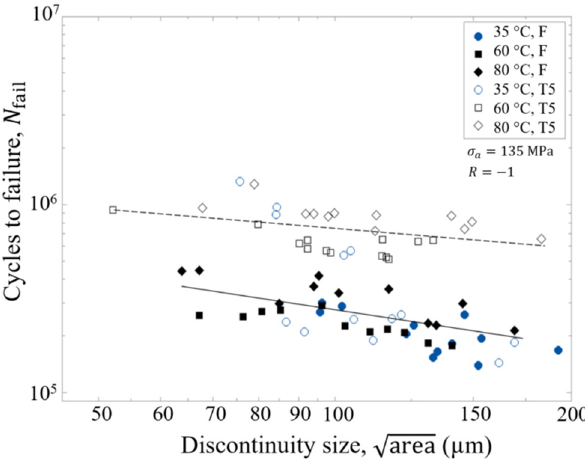
Figure 19. Relationship between number of cycles to failure ( 𝑁 (cid:2916)(cid:2911)(cid:2919)(cid:2922) ) and discontinuity size √area . Fitted line represents specimens produced on X and Z-built conditions at 60 °C and 80 °C. Filled symbols represent F specimens and open symbols represent T5 specimens. The results for the specimens produced at 35 °C (blue circles) were added to the graph for validation purpose. For all tests, the stress amplitude is 135 MPa and 𝑅 = −1 . Table 5. Paris parameters and estimated fatigue models for the additively manufactured AlSi7Mg conditions tested in this work.